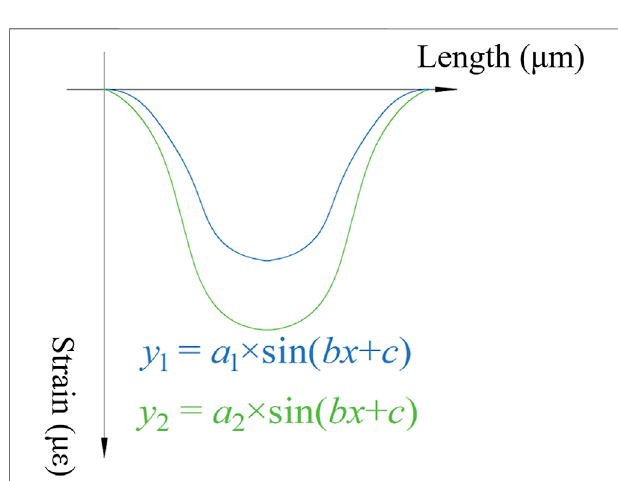
FIGURE 6 | Features of axial strain distribution in hermetic